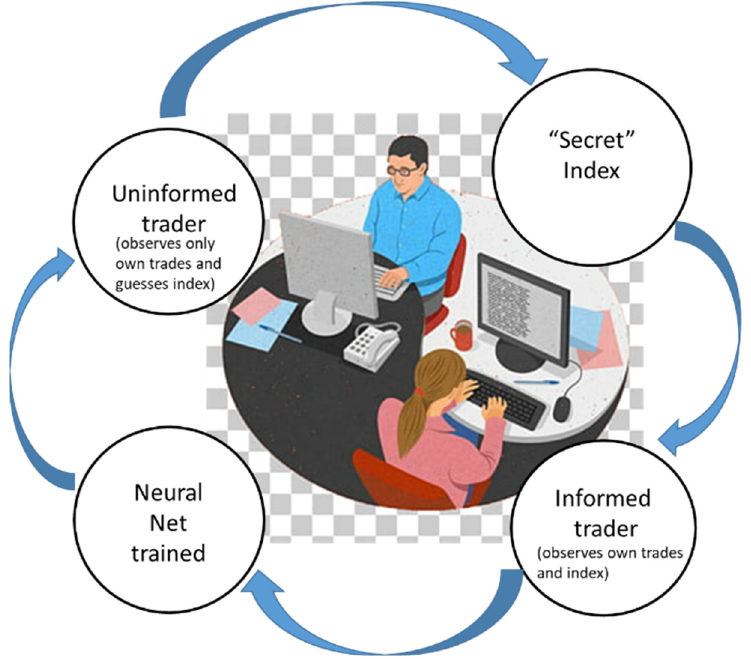
Figure 5. The protocol of our tests. “Informed” trader observes an index and her own orders and trains the net. “Uninformed” trader uses only his own orders and a trained net to backtest the index.